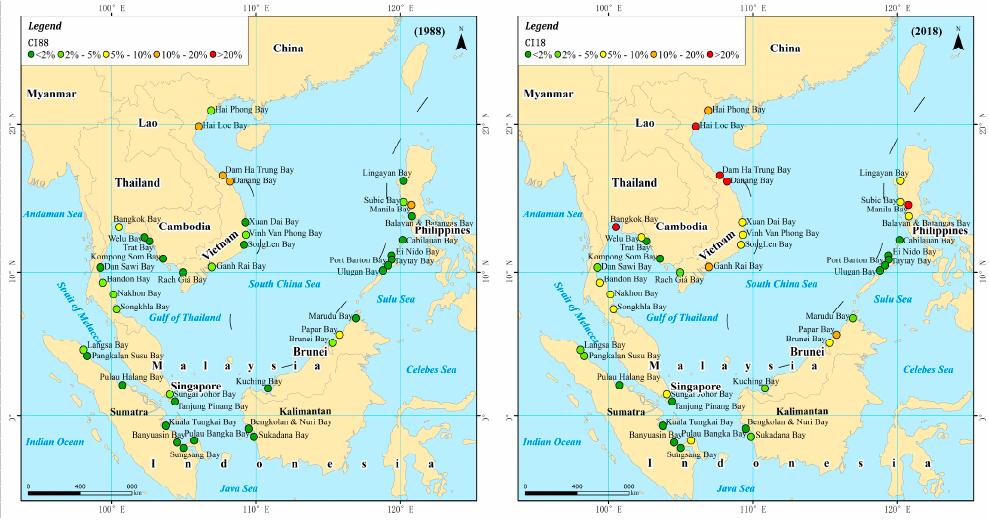
Figure 6. CI of the bays in 1988 and 2018.